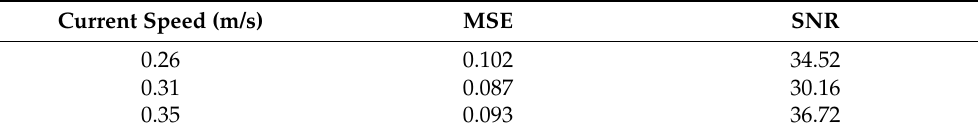
Table 1. Results of MSE and SNR at different